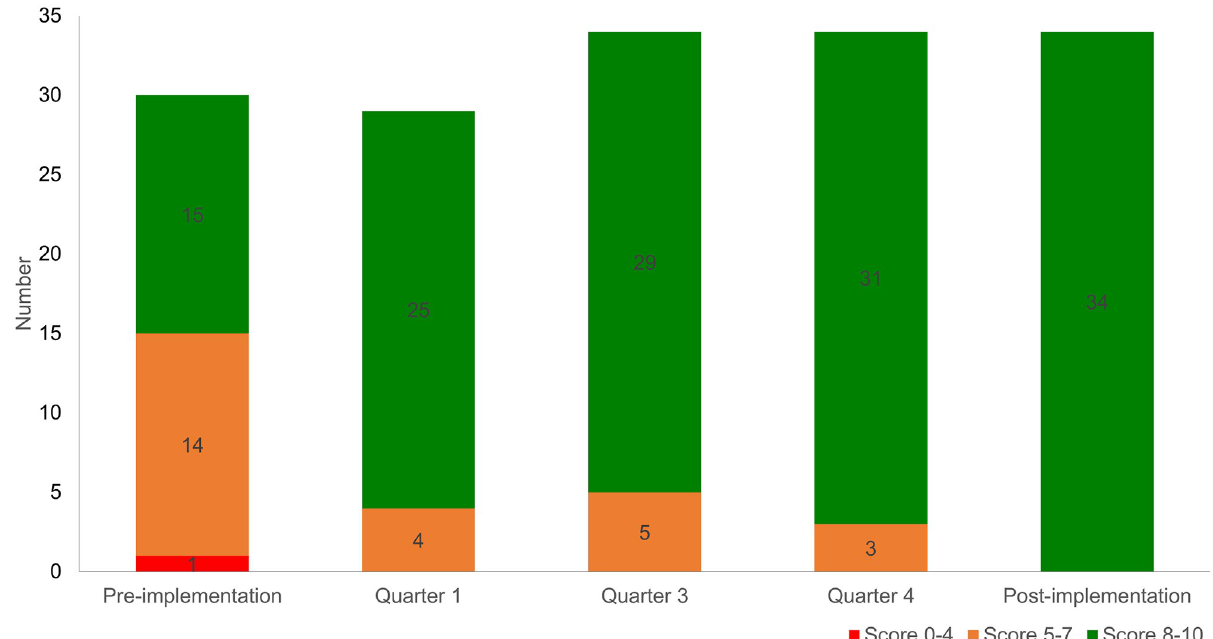
Fig 2. Number of UH&FWCs by readiness score for management of sick young infants with PSBI, by quarter, 2015–2017 (health facility assessment surveys, N: Pre-implementation = 30, quarter 1 = 29, quarters 3, 4 and post-implementation = 34).